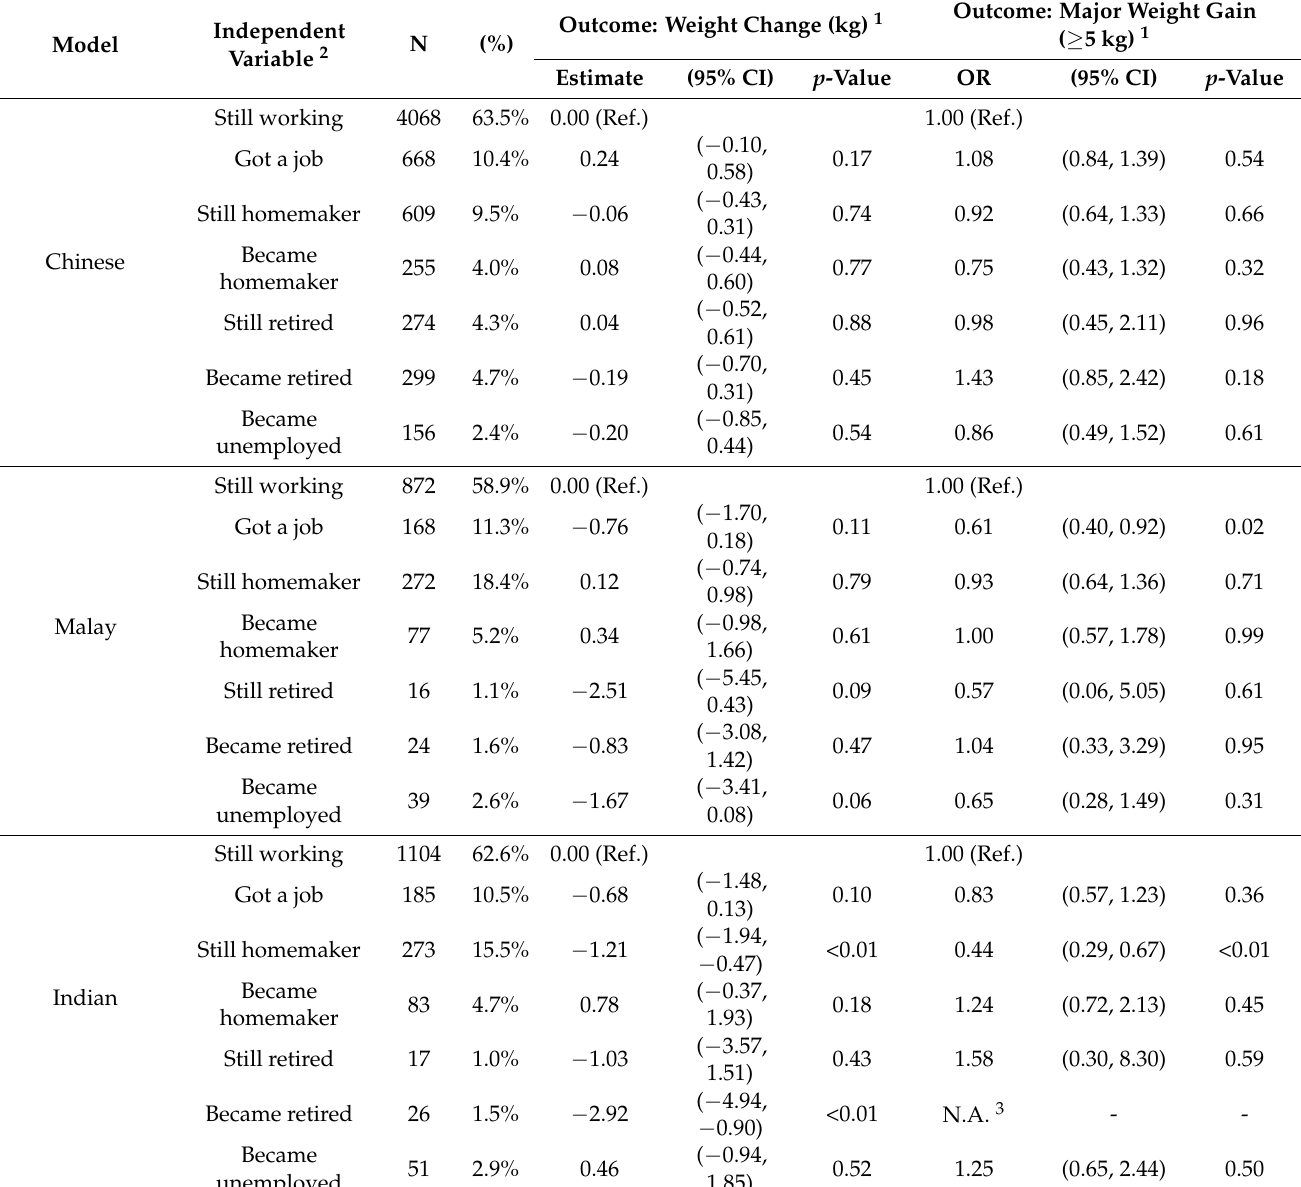
Table 5. Associations between changes in employment status and weight change stratified by ethnicity in Singapore Multi-Ethnic Cohort participants aged 21 years and